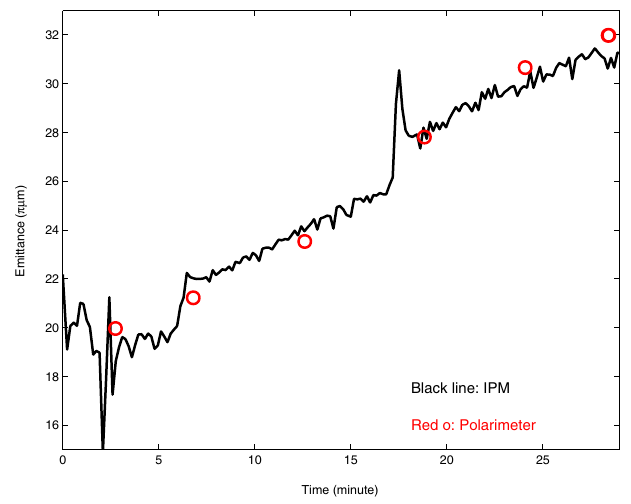
FIG. 4. (Color) Beam emittance growth observed by the IPM for the Blue ring horizontal emittance agrees with the measurement made using the polarimeter target scan.